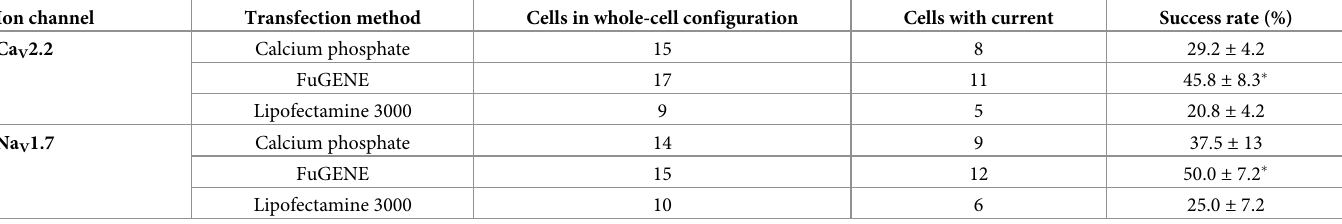
Table 1. Success rates of different transfection methods in the QPatch 16X showing mean ± SEM from N = 3 independent experiments, each testing 8 cells (24 cells per total). Ion